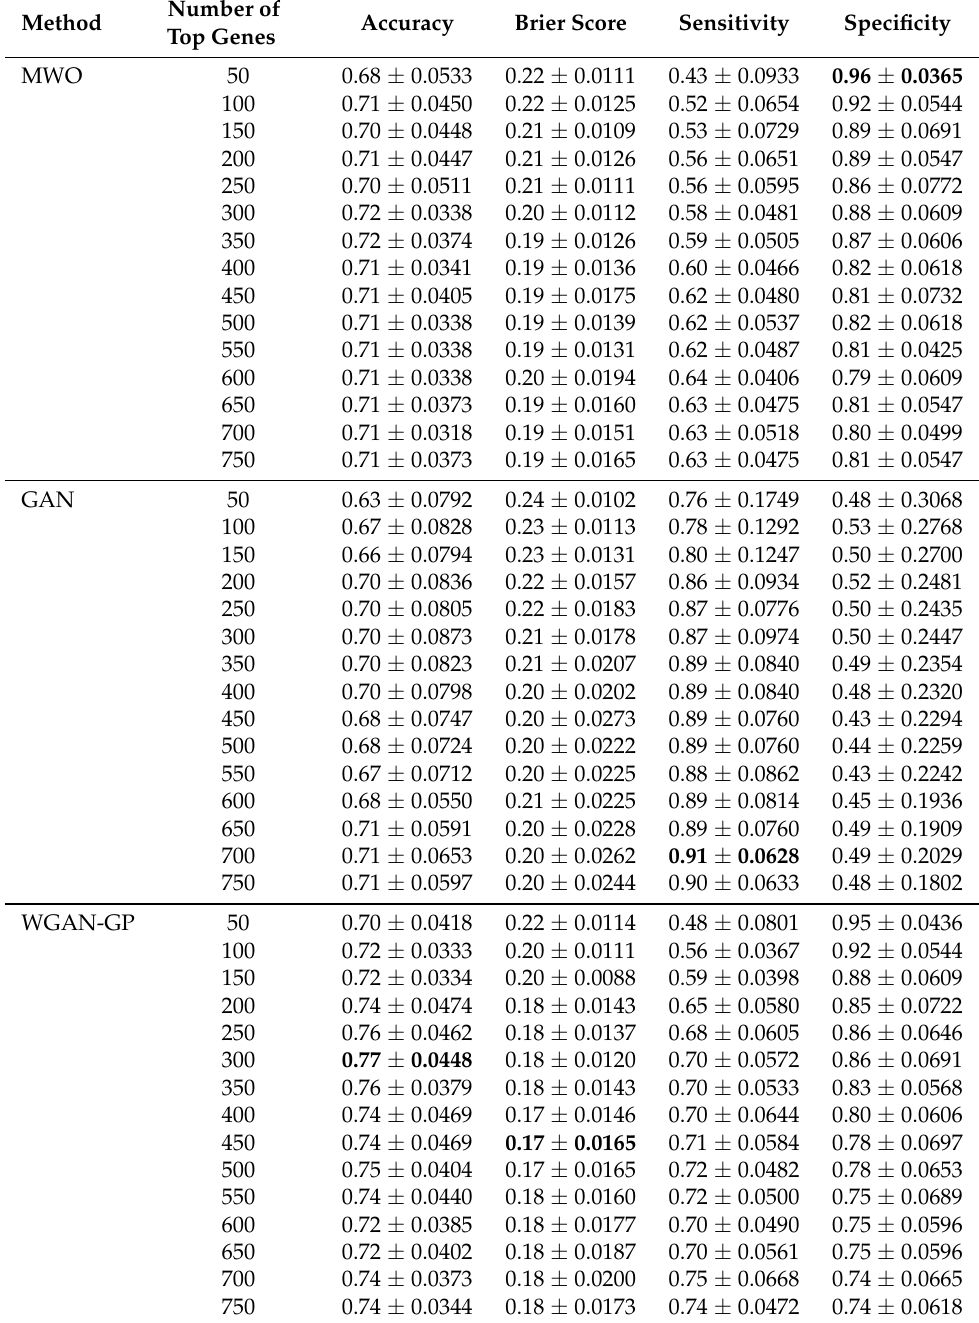
Table 4. Classification performance measures for RNA-seq data (test subsets) after training with augmented training data either augmented with mixed weighted observations (‘MWO’), a standard generative adversarial network (‘GAN’) or the advanced Wasserstein GAN with gradient penalty (‘WGAN-GP’) with the number of synthetic samples being two times the number of original samples in each class, respectively. The table shows the 95% confidence intervals (mean ± 1.96 standard errors) for accuracy, Brier score, sensitivity and specificity, respectively. Values in bold are the best scores for the respective performance